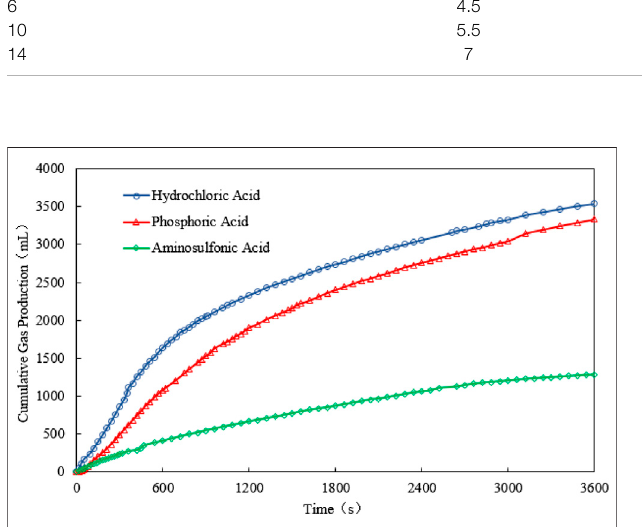
FIGURE 4 | Cumulative gas production vs. time for different catalysts.